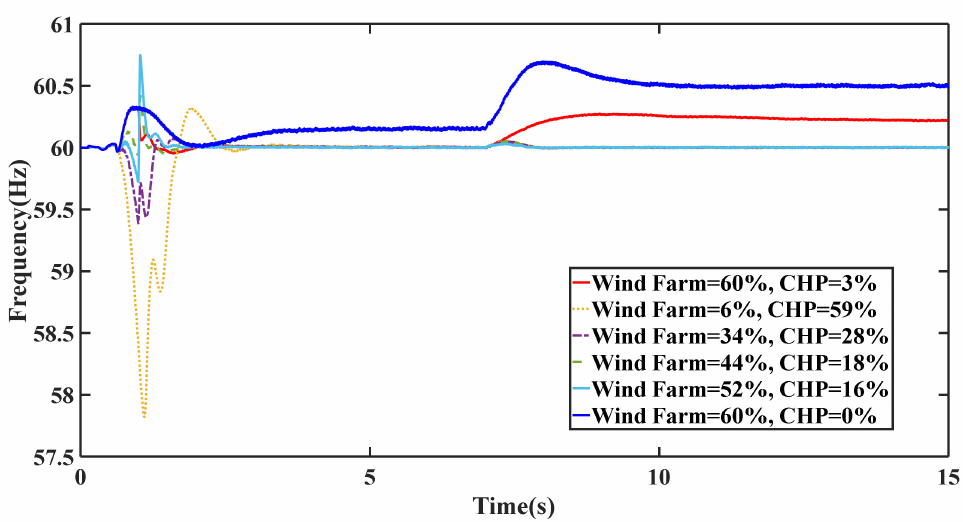
Figure 17. Frequency deviation due to the 10% load changes in the presence of different combinations of inverter-based and droop-based strategies.